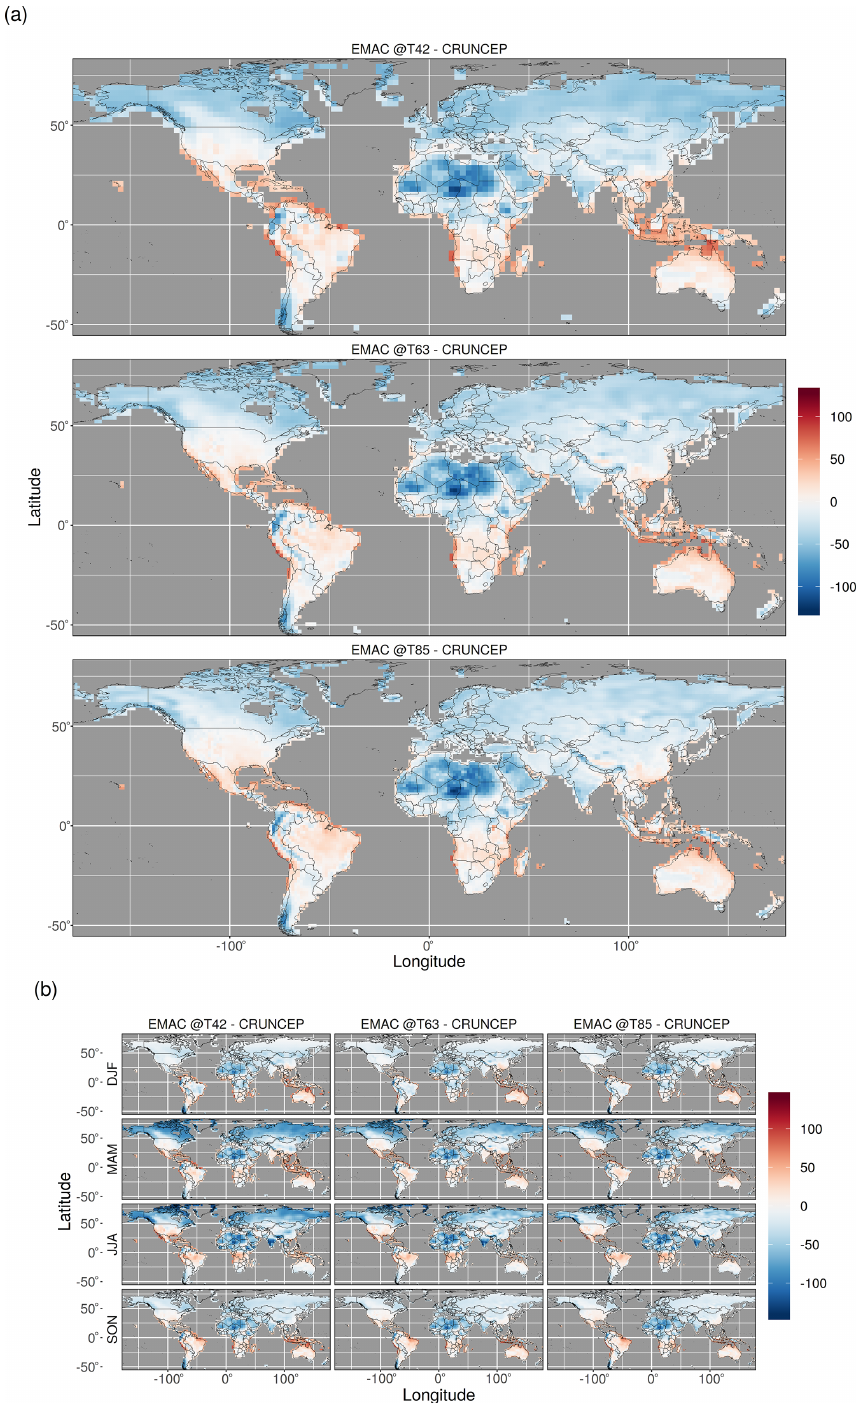
Figure C3. The (a) mean annual net shortwave radiation bias and (b) mean seasonal net shortwave radiation bias between the observed CRUNCEP (1981–2010) and EMAC simulations (last 50 years of simulation). Note that these plots compare the radiation available for vegetation in the CRUNCEP- and EMAC-forced LPJ-GUESS simulations; consequently, the gross shortwave radiation has been adjusted by different albedo values. The CRUNCEP gross shortwave flux has had the standard LPJ albedo value of 0.17 applied (temporally and spatially invariant), and the EMAC gross shortwave flux has had the spatially and temporally varying albedo values in the land surface scheme